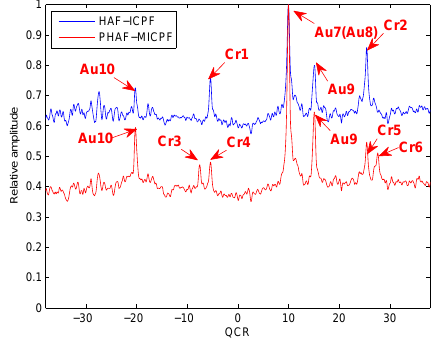
Figure 7. Cross-term suppression of